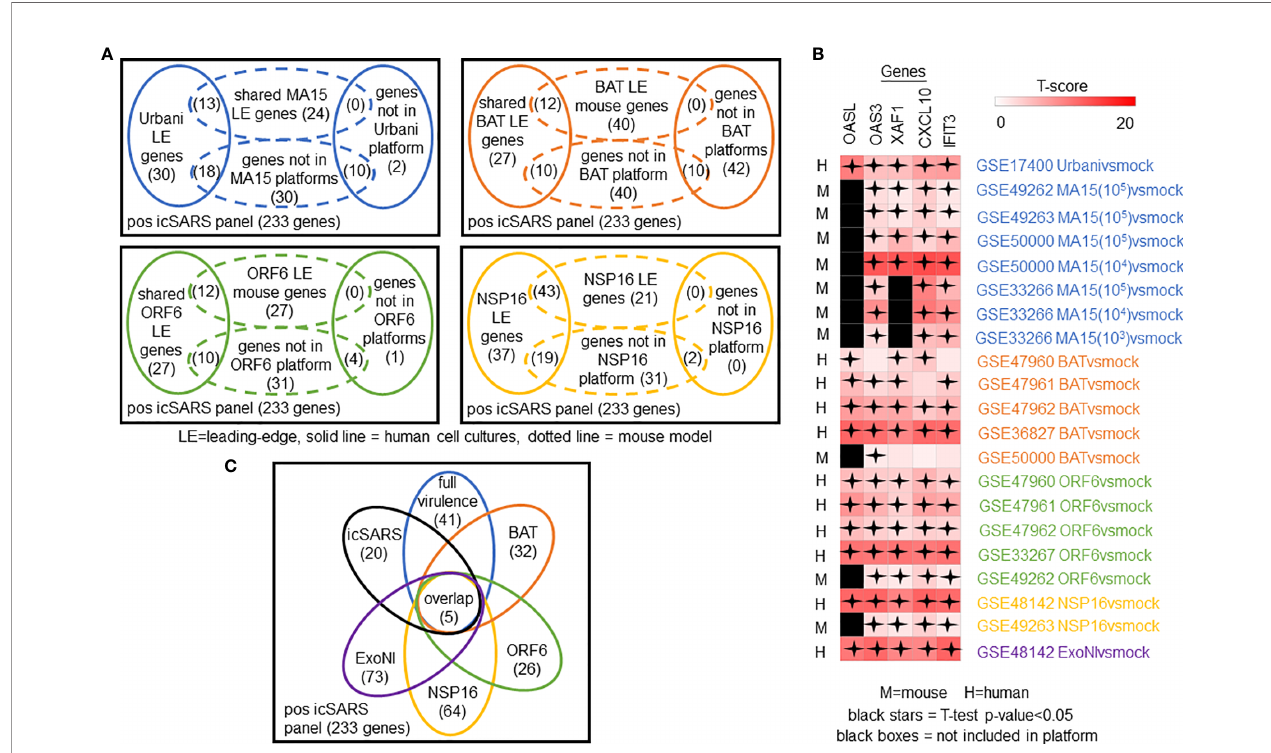
FIGURE 5 | Meta-analysis Across 28 Gene Signatures Representing Seven SARS-CoV Strains Varying in Virulence Identi fi ed Five Over-Expressed Genes Associated with SARS-CoV Infection. (A) Venn diagrams of the inclusion and overlap of positive icSARS panel genes in identi fi ed leading-edges and dataset platforms from human and mouse gene signatures shared in individual strains of SARS-CoV. (B) Venn diagram of the inclusion and overlap of shared positive icSARS panel genes identi fi ed in SARS-CoV leading-edges across individual strains of SARS-CoV. (C) Heat map of T − scores for the fi ve positive icSARS panel leading-edge genes identi fi ed in (B)